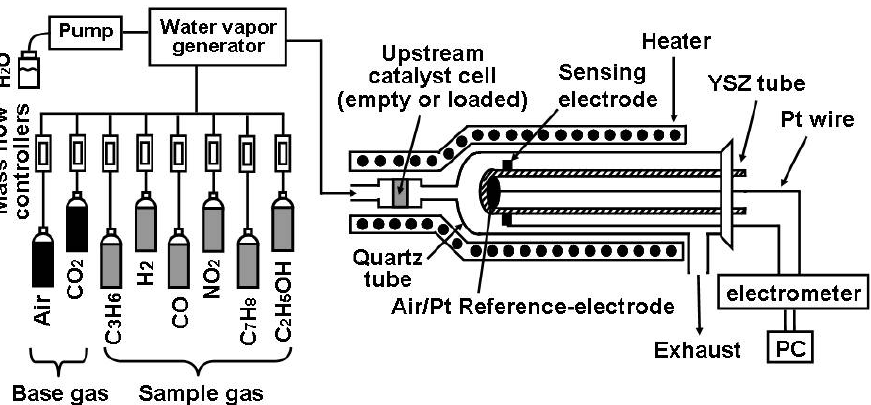
Figure 1. Schematic view of the gas sensor evaluation